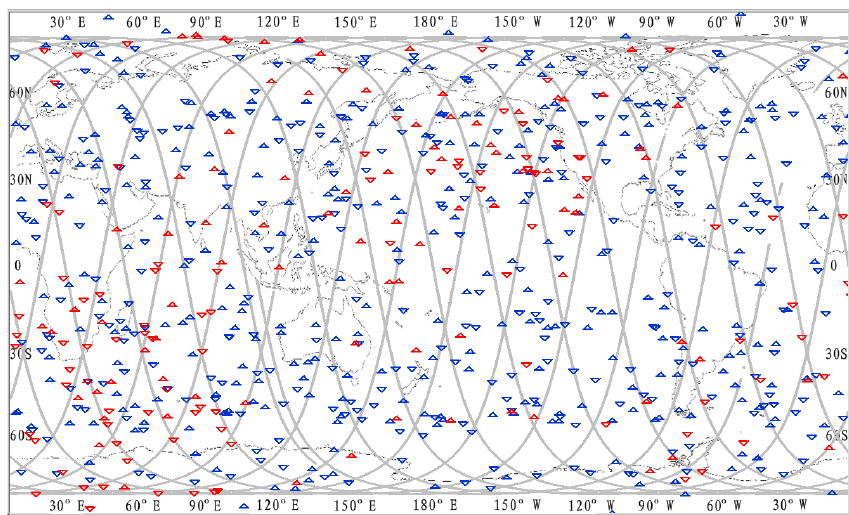
Figure 4. Distribution of the FY3 C-GNOS radio occultation events on 2 October 2013. There were 94 rising BDS RO events (upward- pointing red triangle), 90 setting BDS RO events (downward-pointing red triangle), 287 rising GPS RO events (upward-pointing blue trian- gle), and 256 setting GPS RO events (downward-pointing blue triangle) (source: Wang et al., 2015).